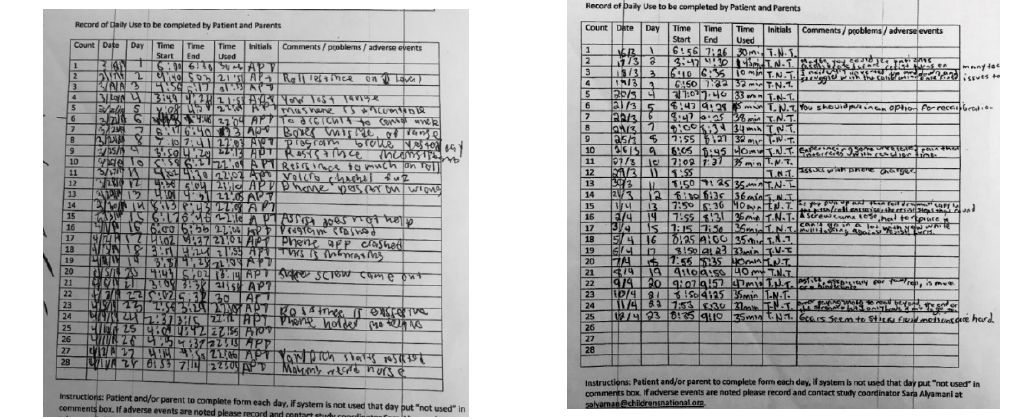
Figure 4. Detailed research logs kept by two children, age 16: boy, left; girl, right.